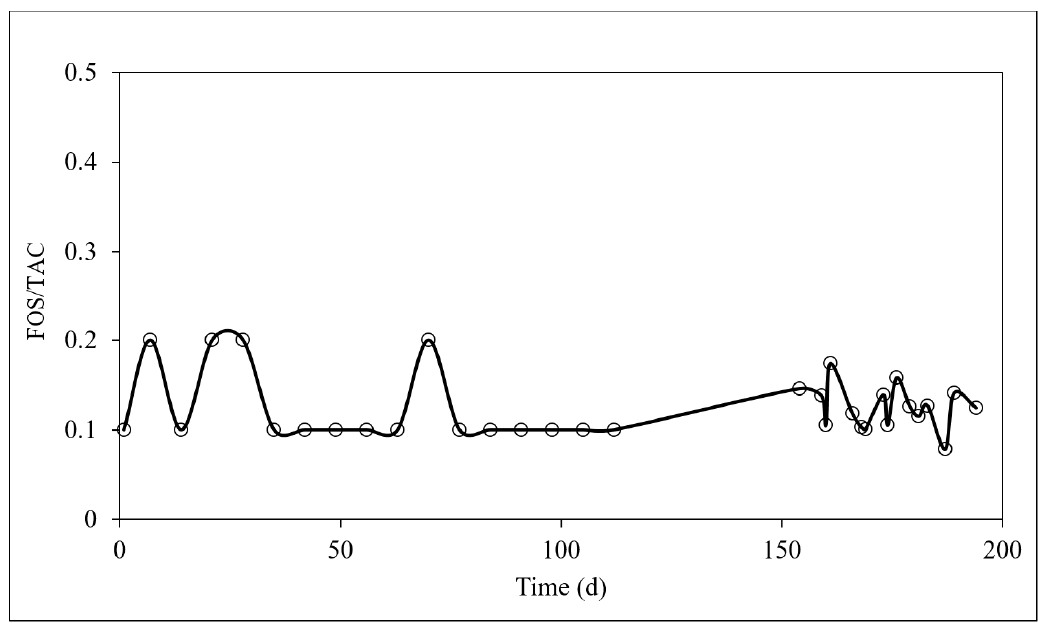
Figure 6. Variation of the FOS/TAC ratio during the reactor operation.